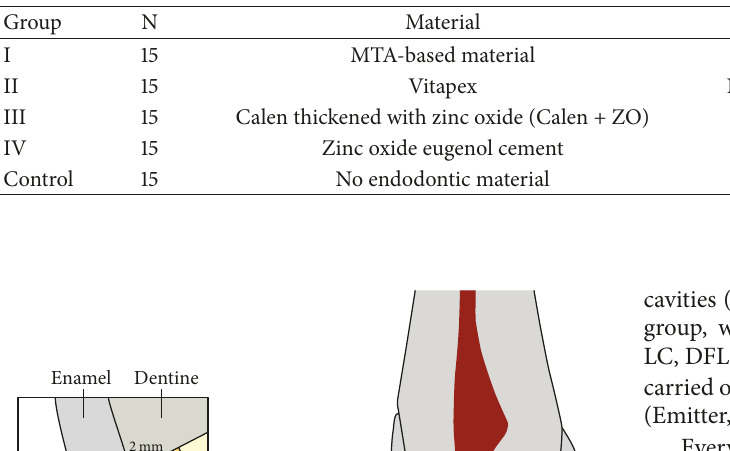
Table 1: Distribution of experimental materials.